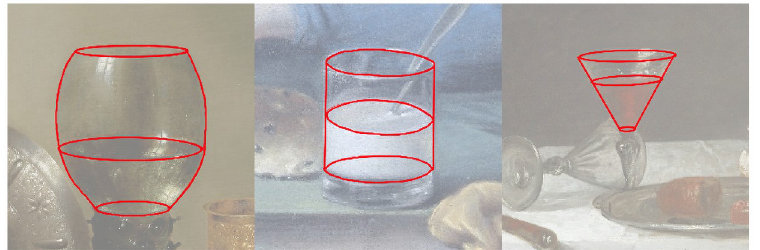
Fig 3. Examples of the three glass shapes. From left to right: spherical, cylindrical and conical. The red geometry annotations were manually created by the authors, and were used to standardize across glasses for the highlight analysis. Paintings used, from left to right: Portret van een jongen, zittend in een raamnis en gekleed in een blauw jasje , by Jean Augustin Daiwaille . 1840. Still Life with a gilded Beer Tankard , by Willem Claesz. Hed , 1634. The White Tablecloth , by Jean Baptiste Siméon Chardin , 1731. The left and middle images courtesy of The Rijksmuseum. The right image courtesy of The Art Institute of Chicago. All images reproduced under a CC0 license.